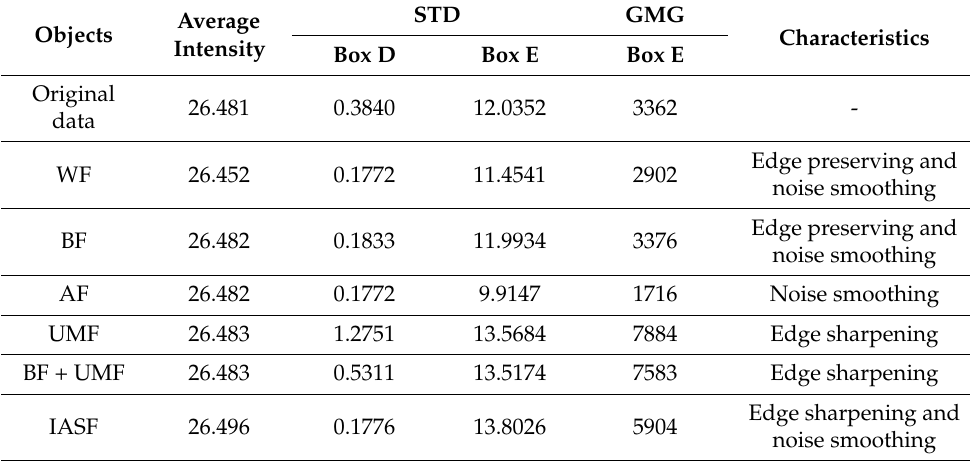
Table 3. The comparison results for image data of target 2.